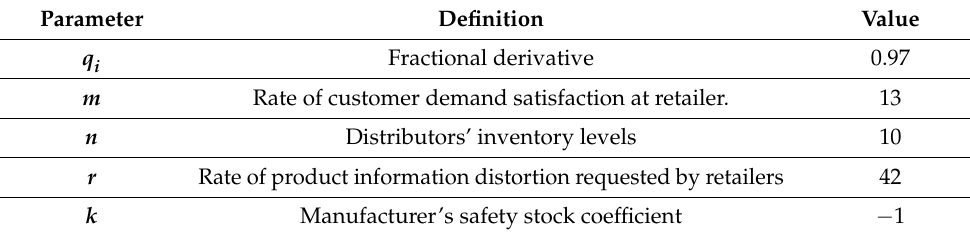
Table 2. Parameters of the systems as well their definition and value.